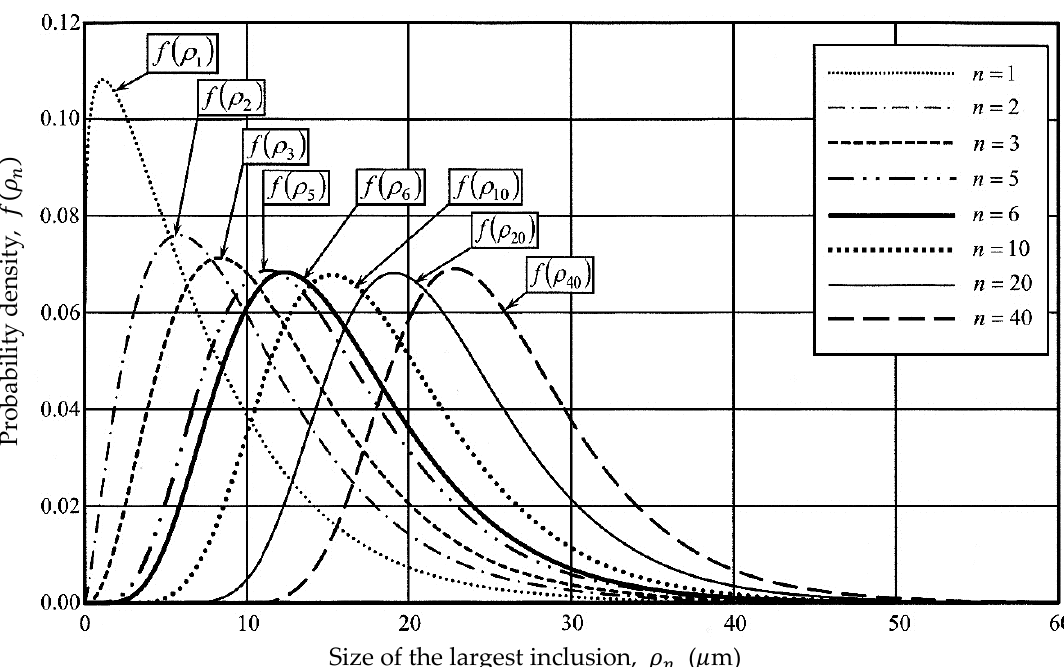
Figure 4. Probability density functions of the largest inclusion size among various numbers of inclusions.